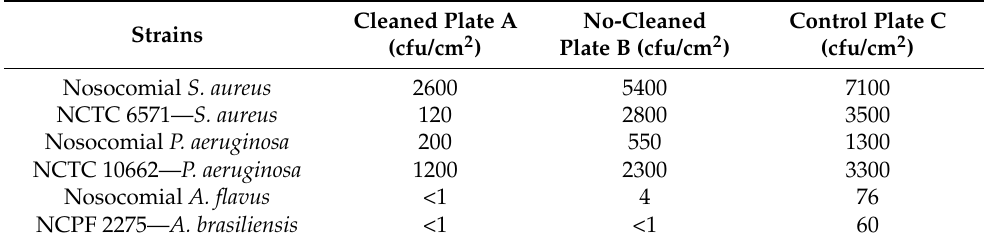
Table 2. TBC and TFC (cfu/cm 2 ) of stainless-steel plates inoculated with nosocomial and standard reference